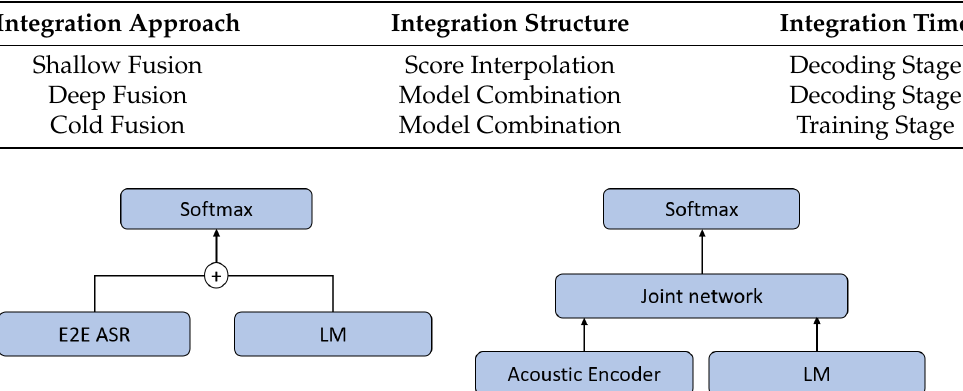
Figure 1. LM integration approach structure comparison. The left side is shallow fusion, while the right side is deep and cold